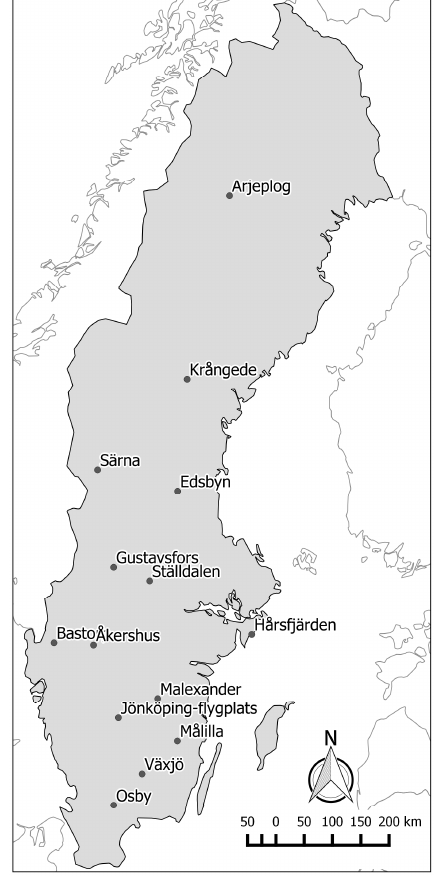
Figure 1. Map showing the locations of the observation